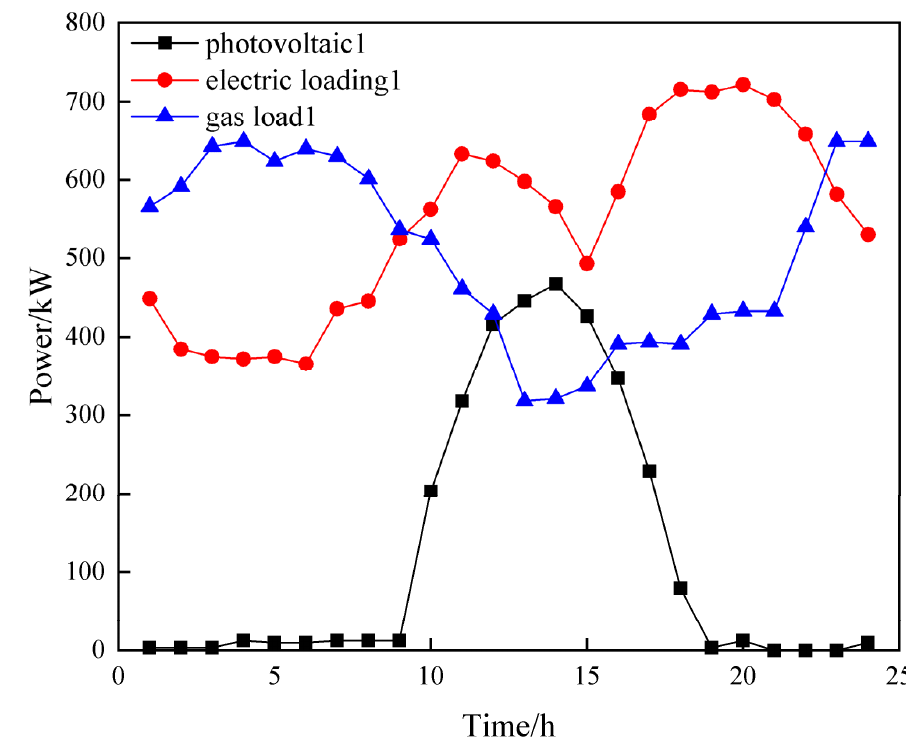
Figure 3. Predicted values of renewable energy output and load in system 1.